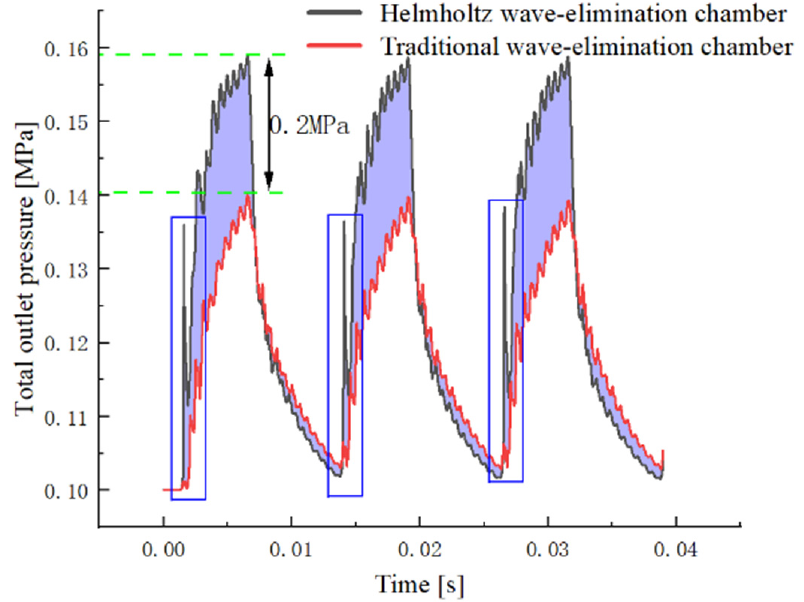
Figure 6. Outlet pressure of the two chambers.